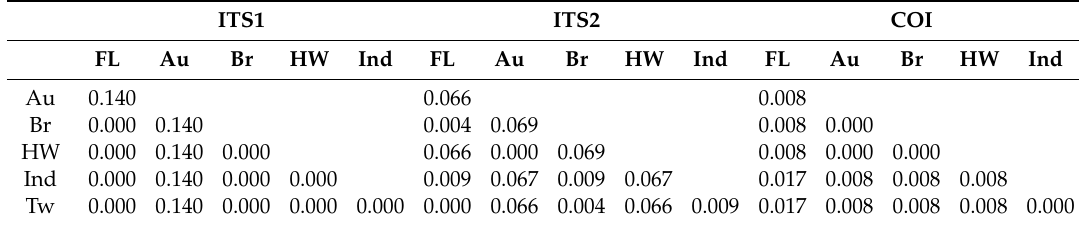
Table 3. Pairwise K2P distances between the A. litchii from six